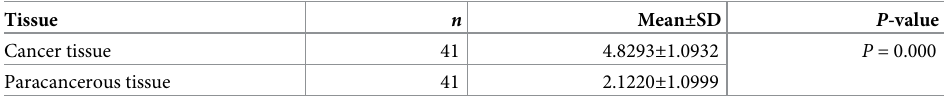
Table 1. Expression of COPB2 in colorectal cancer and paracancerous tissue by IHC staining. Tissue